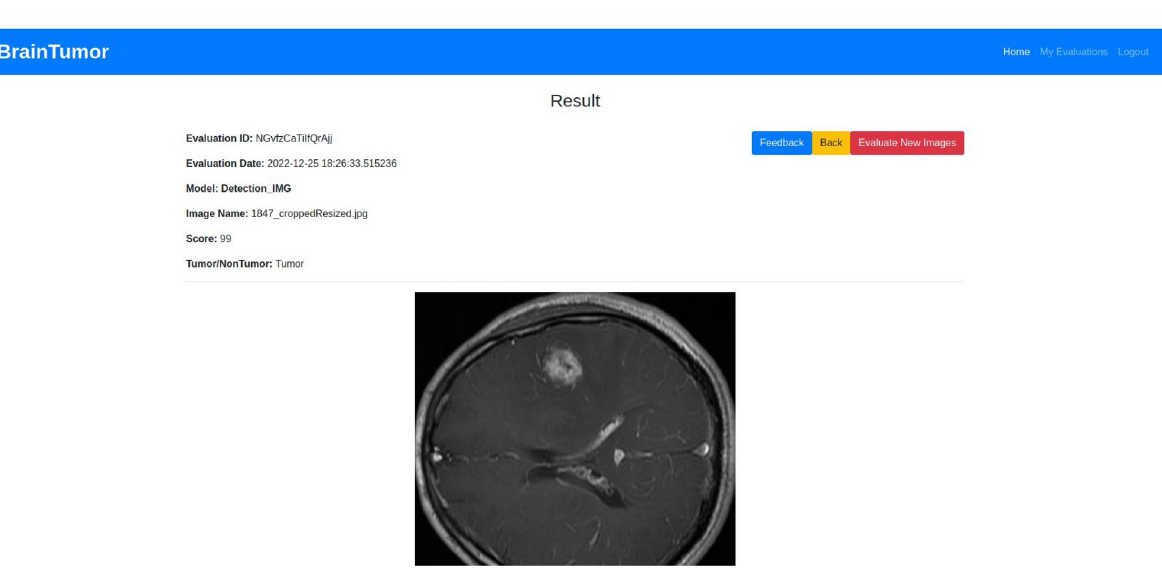
feature based prediction model was also added as an option to the UI. Fig 23 shows the com- parison in a graph where the red line represents the prediction accuracy, the green line repre- sents the training accuracy and the yellow line refers to the validation accuracy for the MRI CNN features, intensity features, GLCM features, DWT features, other features and all (i.e. intensity, GLCM, DWT, other) features.